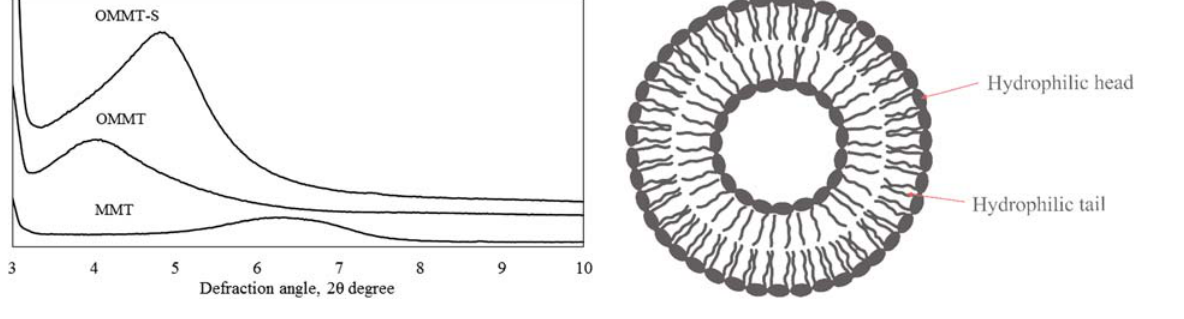
Figure 3: XRD di ff ractograms of OMMT and OMMT - S. Figure 4: Proposed structure for the gelling